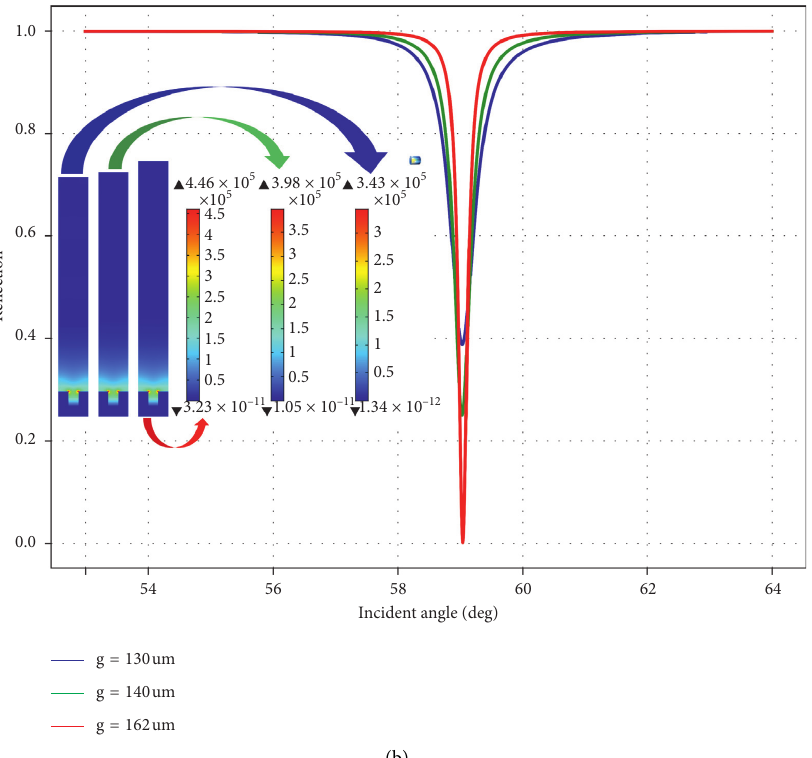
Figure 4: Reflectivity spectrums as a function of resonance frequency (a) and incident angle (b) and the electric field amplitude distribution of different gap distances at nd � 1.025.